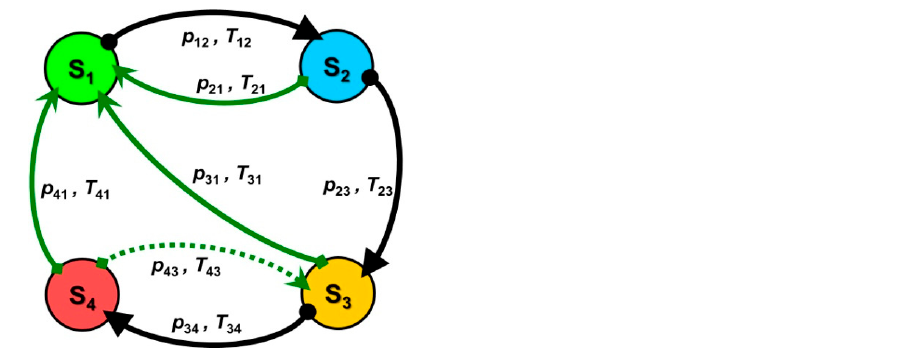
Figure 8. The graph of state changes 𝑠 (cid:3036) ∈ 𝑆(𝑖 = 1,2,3,4) of the process {𝑊(𝑡):𝑡 ≥ 0} [4] .